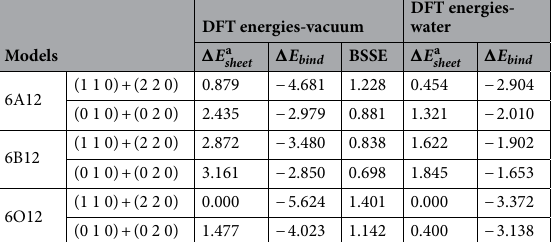
eventually stabilize, and more extension of DP will no longer affect its total energy. For the effect of the number of